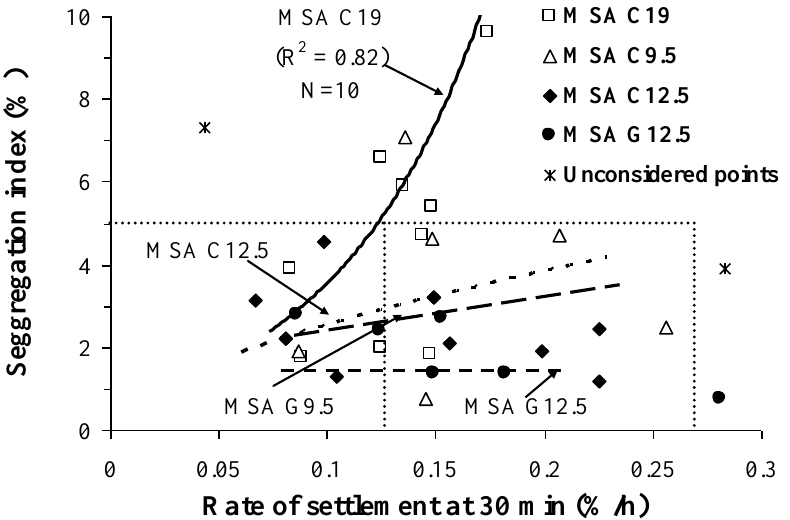
Figure 5. Variation in column segregation index with rate of surface